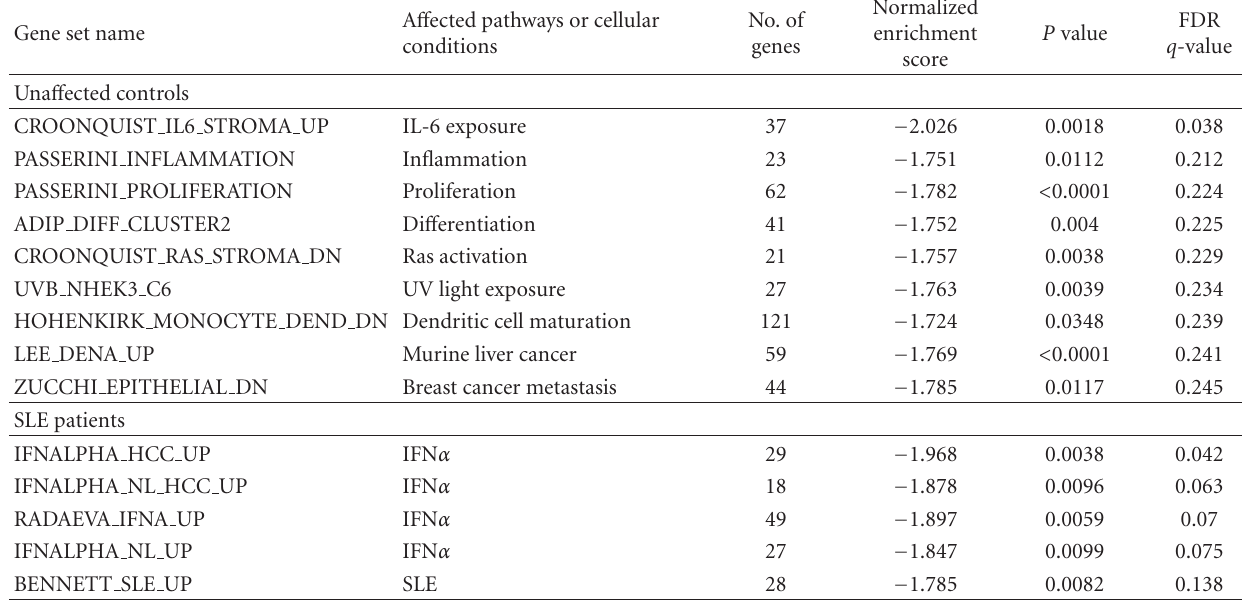
Table 2: E ff ect of the IRF5 risk haplotype on the expression of gene sets. Gene set enrichment analysis showed gene sets enriched in the risk haplotypes of either SLE-una ff ected controls or SLE patients without EBV infection. Genes shown have a false discovery rate (FDR) of <